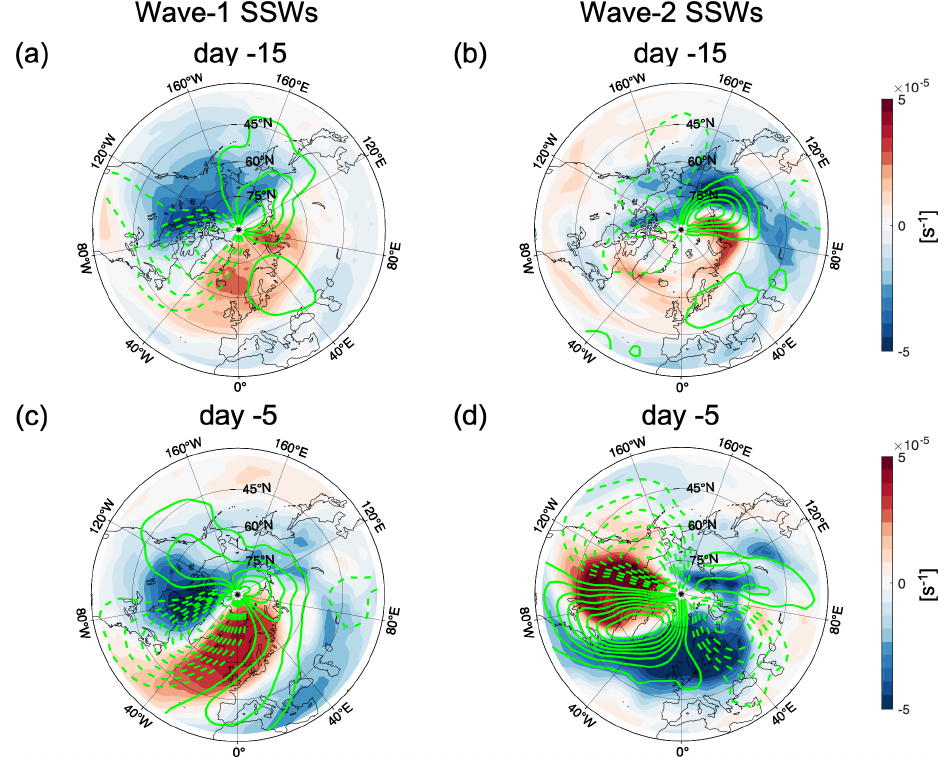
Figure 9. The spatial pattern of anomalies of PV and meridional wind after removing the daily climatology and zonal mean values (a, b) on day − 15 and (c, d) on day − 5. Panels (a, c) show the composites of wave-1 SSWs, and (b, d) show the composites of wave-2 SSWs. Shading is for the PV anomalies ( P ∗∗ a ), and the green contour is for the meridional wind anomalies ( v ∗ a ) with dashes for negative values. The contour interval of v ∗ a is 10ms − 1